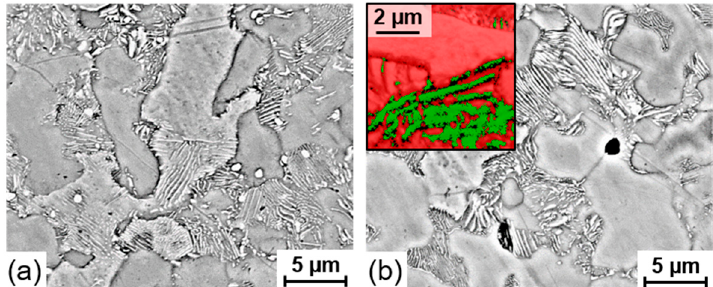
Figure 10. SEM micrographs of the base material ( a ) and the weld junction ( b ) in normalized condition, inset shows results of EBSD analysis with orthorhombic M3C (green) and bcc ferrite (red) crystal structure and microstructure.